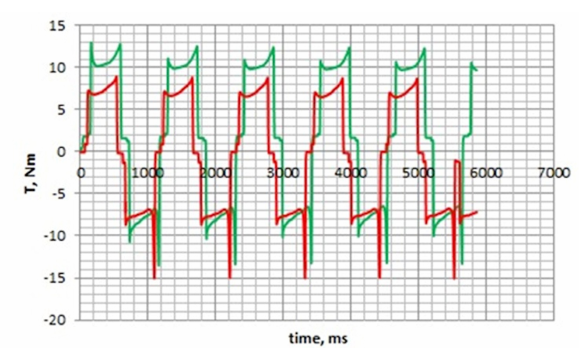
Figure 11: The course of the friction torque value in initial cycles (green) and final cycles (red) registered in valve sealed with variant 2